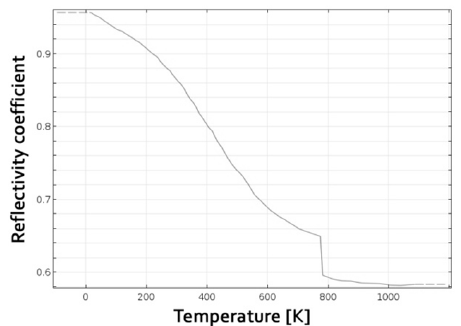
Figure 2. Aluminum reflectivity coefficient as a function of temperature.